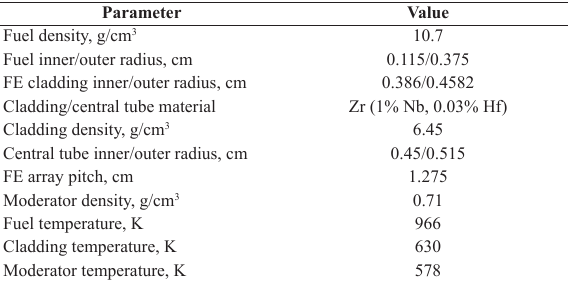
Table 1. VVER-100 unit cell parameters (Subrata 2008).